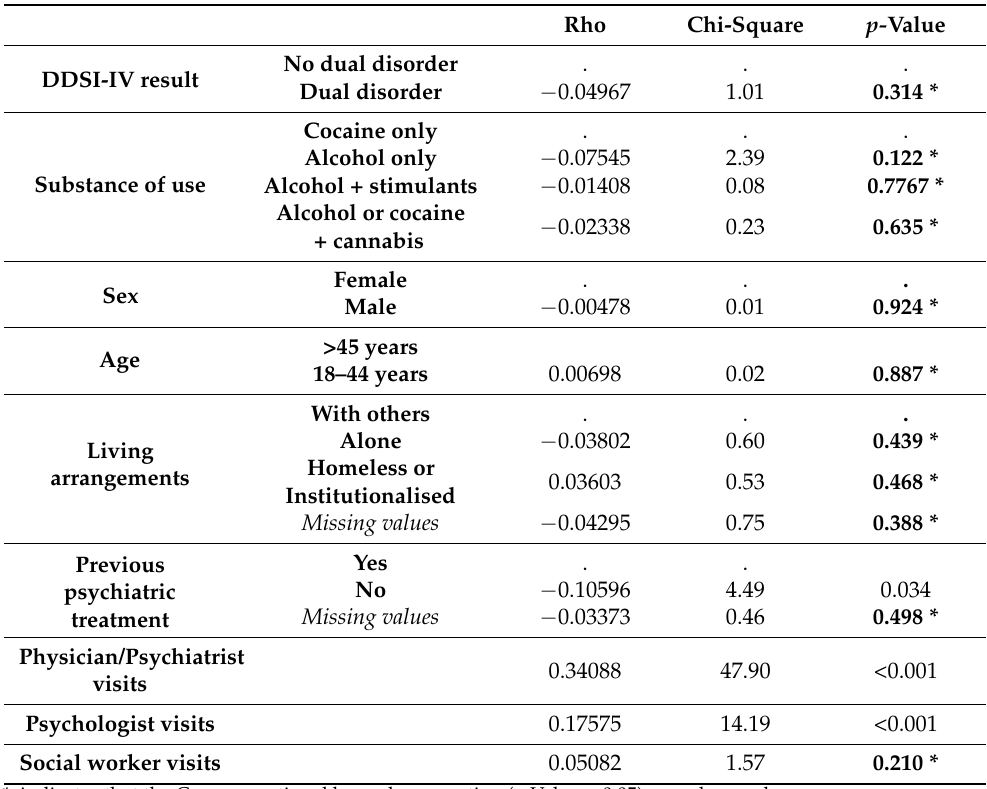
Table A2. Assessment of the proportional hazards assumption of the final Cox regression model (model